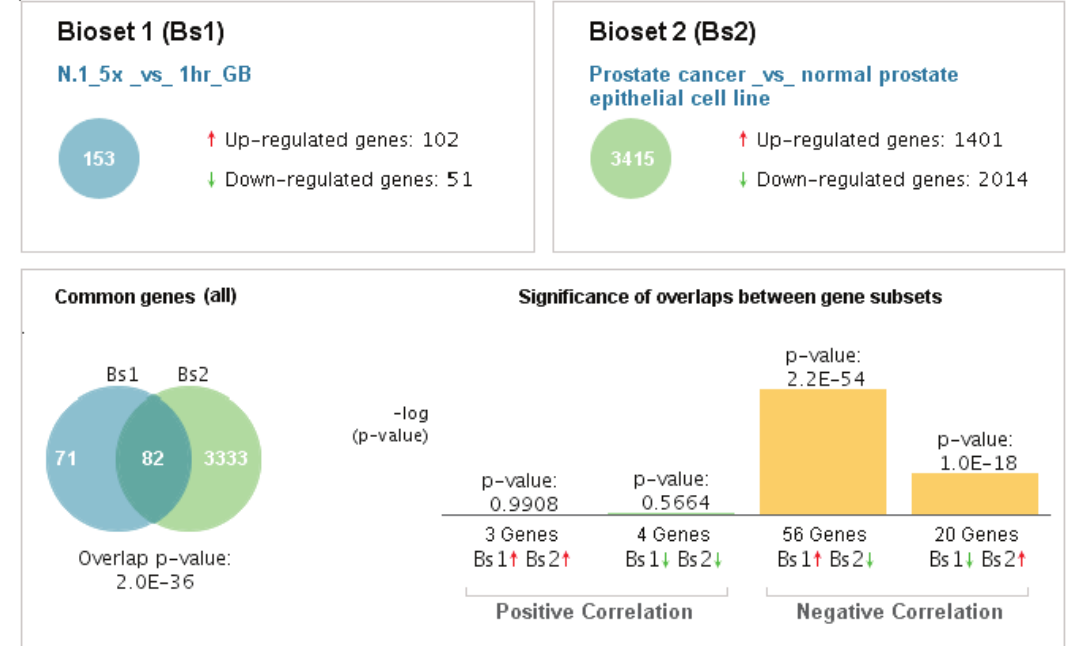
Figure S6. Overlap in mRNA expression between the 5× dataset and in human prostate cancer derived cell lines. ( A ) The top panels summarize the datasets: Bioset 1 = 5× dataset of mRNAs affected by NKX3.1 expression; Bioset 2 = Prostate cancer derived cell lines versus normal prostate epithelial cells 2 . The bottom panel illustrates the overlap between Bioset 1 and Bioset 2 in a Venn diagram (left) and in bar graphs (right). The bar graph highlights the largely opposite gene expression patterns in the two biosets. The individual genes are indicated in Supplementary Table 1 and Supplementary Table 2.